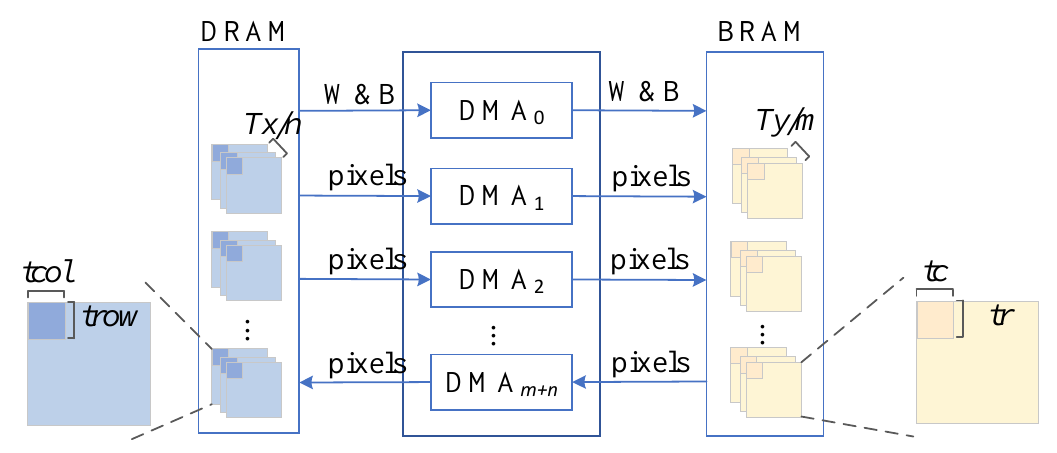
Figure 8. Multichannel